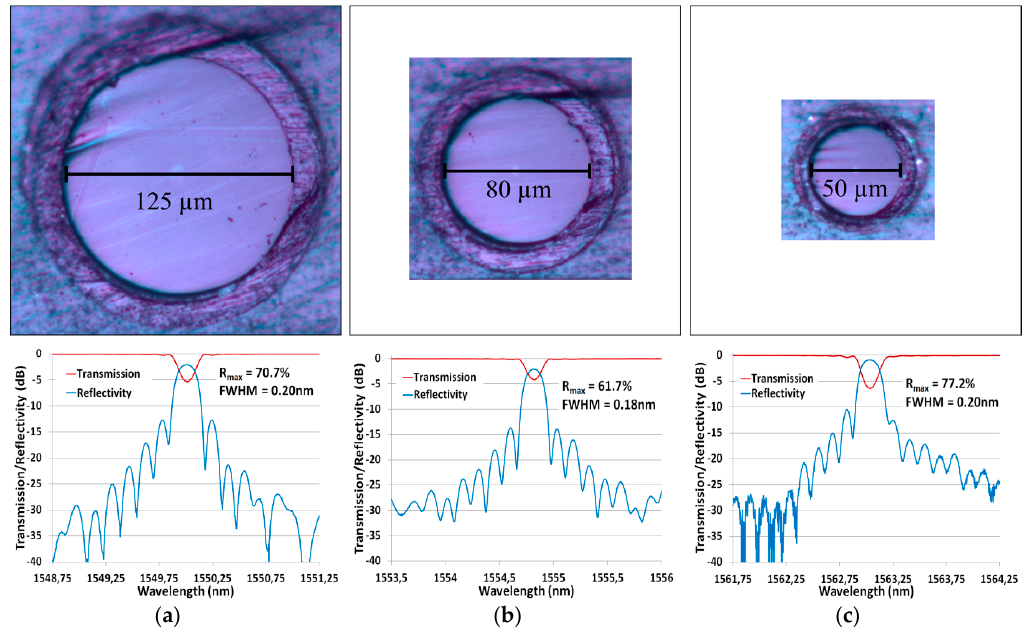
Figure 7. ( Top ) Optical microscope images of the polished cross-section for 125, 80 and 50 µm cladding diameter fibers; and ( Bottom ) their corresponding transmission and reflectivity spectra. Fibercore’s fibers are: ( a ) SM1500(9/125)P; ( b )SM1500(5.1/80)P; and ( c ) SM1500(4.2/50)P. Note that ( c ) was D 2 -loaded prior to inscription to reach the targeted